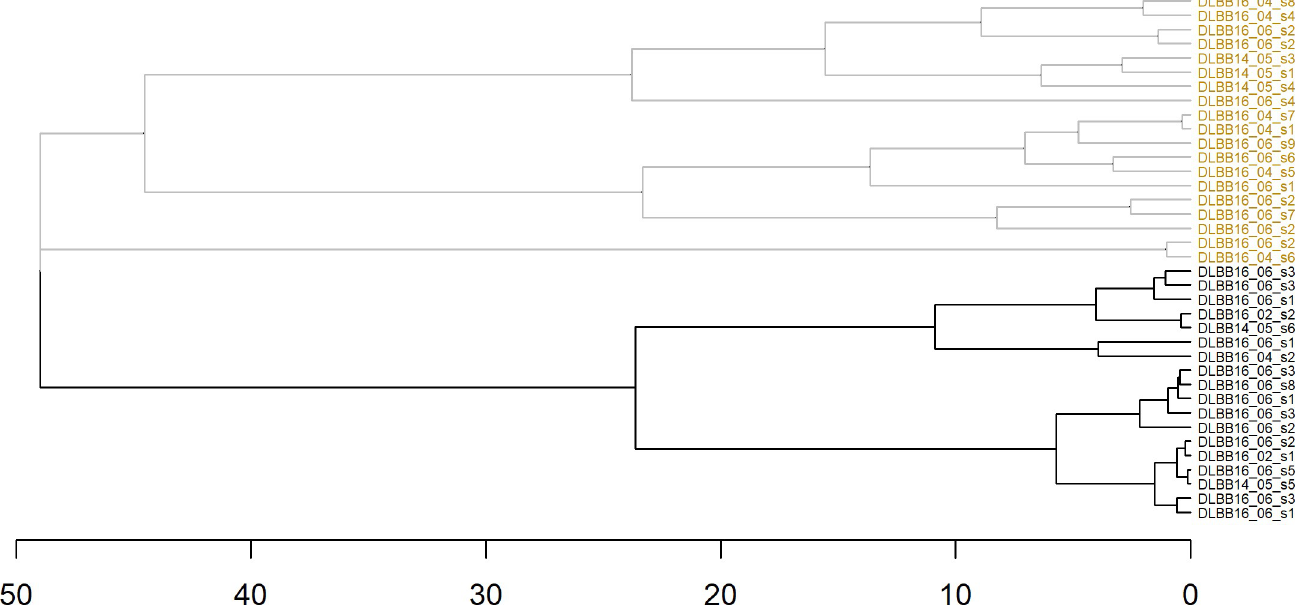
Fig 7. Dendrogram from the 2 top-performing cluster algorithms using agglomerative hierarchical methods, Euclidean distance, Ward’s minimum variance linkage criterion, unscaled data, and all 5 variables (minICI, maxICI, ICIr, ICIir, and slope) or 2 variables (minICI and ICIir) from a sample of 18 feeding click trains (black font color) and 19 social buzzes (yellow font color) from Bristol Bay beluga tagged with DTAG v3.